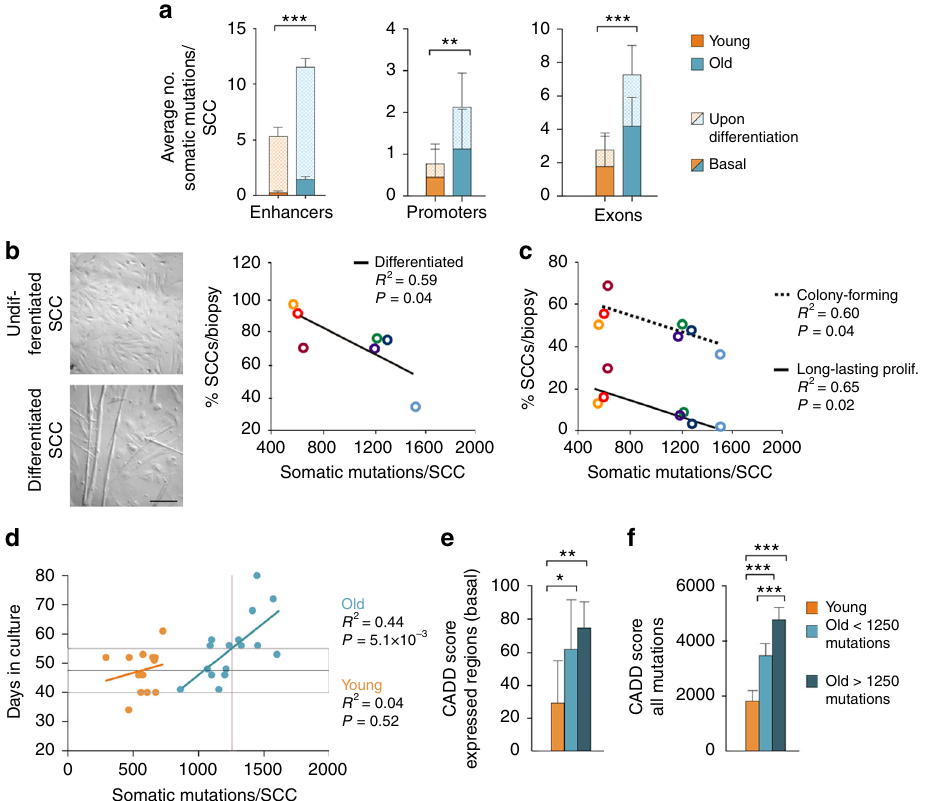
Fig. 3 Mutation burden affects the satellite cell function. a Average number of mutations (SNVs + indels) in the speci fi ed genomic regions of young and old clones. The enhancers, promoters, and exons include only those regions that are actively transcribed during the differentiation of myoblasts to myotubes according to the FANTOM5 data 28 . Basal: regions expressed in SCs before induction of differentiation; upon differentiation: expressed only after differentiation treatment (see Methods). ** P < 0.01, *** P < 0.001 two-sided t -test of average number of mutations in expressed regions (basal + upon differentiation) per clone. b An example of SCC cells in undifferentiated (growing medium 20% serum, top) and differentiated (1% serum, bottom) state and quanti fi cation of the percentage of SCCs that are able to differentiate after 5 days. Scale bar, 500 μ M. A linear fi t of the percentage of differentiated SCCs and the average number of somatic mutations per biopsy is shown. A subset of SCCs that failed differentiation was tested for MyoD expression to exclude their non-myogenic origin (CES3 n = 4, CES6 n = 3, CES7 n = 2, CES8 N = 5). c For every biopsy (young n = 3, old n = 4 individuals), at least 96 SCs were plated and the percentage of cells able to form a colony after 2 weeks in culture (colony forming) and the percentage of cells able to grow up to 30,000 – 100,000 cells (long-lasting proliferative potential) were registered. Linear fi t of proliferation parameters with the average number of mutations detected in SCCs from each of the seven muscle biopsies included in the study is shown. d Linear fi t between the time required for a single SC to proliferate to 30,000 – 100,000 cells (~17 divisions) and the number of somatic mutations/SCC. No correlation was found for young SCCs (orange line), in line with mutation burden compatible with healthy proliferation in young cells. The normal time in culture for a healthy clone (boxed area) was thus de fi ned as the average (gray line) ± standard deviation of time in culture of young clones ( n = 13). The intersection between the higher border of the boxed area and the linear regression curve for old SCCs (blue line) de fi ned the maximum threshold of mutations above which SC proliferation is compromised (purple line, 1250 mutations). e , f The pathogenic effect of mutations, predicted using CADD (Combined Annotation Dependent Depletion). The global score was calculated as the sum of CADD PHRED-like scores of mutations found in either basally transcribed regions described in Fig. 3a ( e ) or in the whole genome ( f ). Bars show the average value per SCC in the young, healthy old (carrying < 1250 mutations, n = 9) or diseased old (> 1250, n = 7)